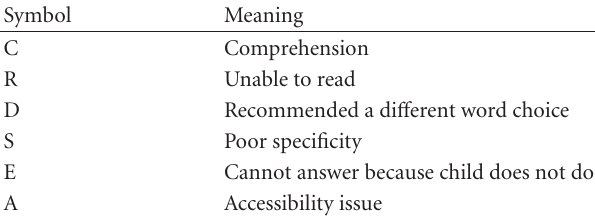
Table 2: Cognitive interview coding for problematic